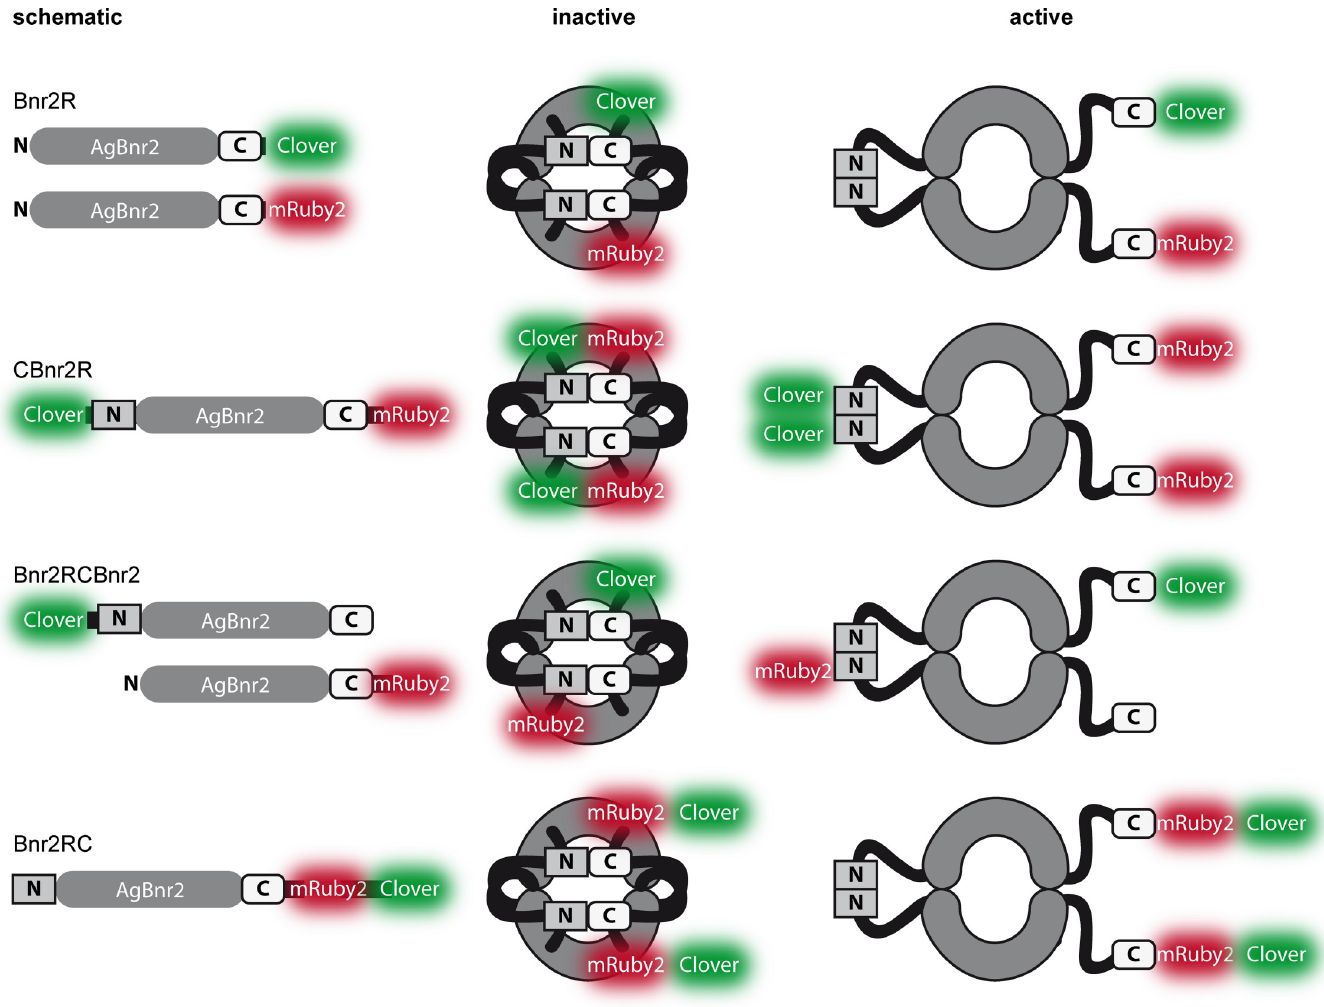
Fig 3. Schematic and possible conformations of the different AgBnr2 constructs used for FRET-measurements. The inactive and active forms are based on current hypotheses of formin regulation (Chesarone et al., 2010).